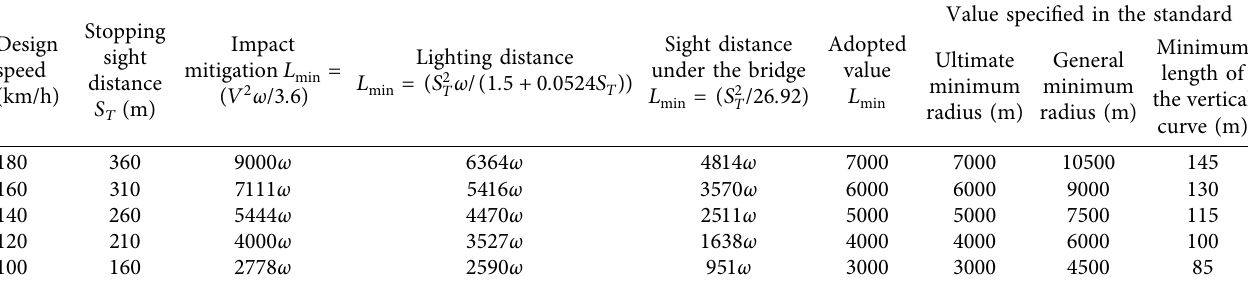
Table 15: The minimum radius of a concave vertical curve of a